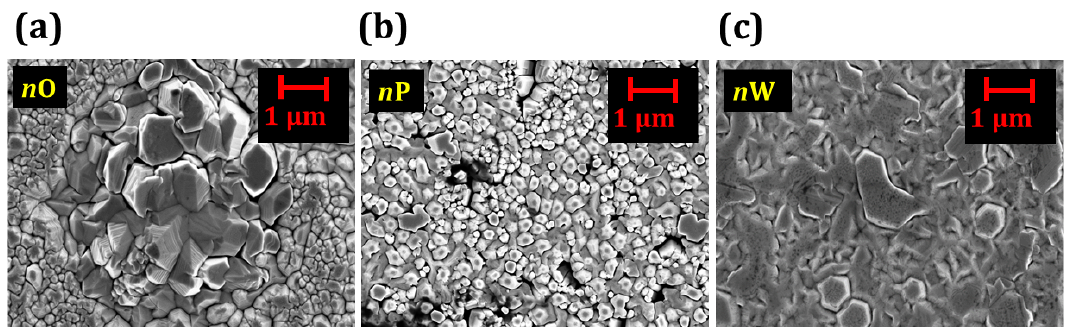
Figure 4. Planar view of FESEM image for ( a ) nO, ( b ) nP, and ( c ) nW are shown.